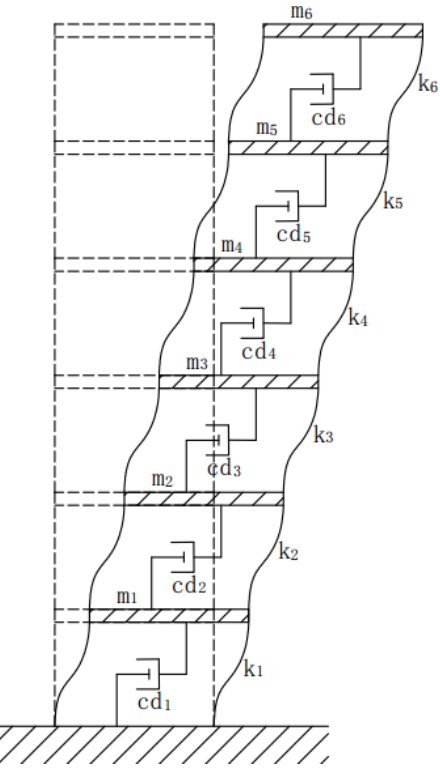
Figure 3. Six-story plane frame.